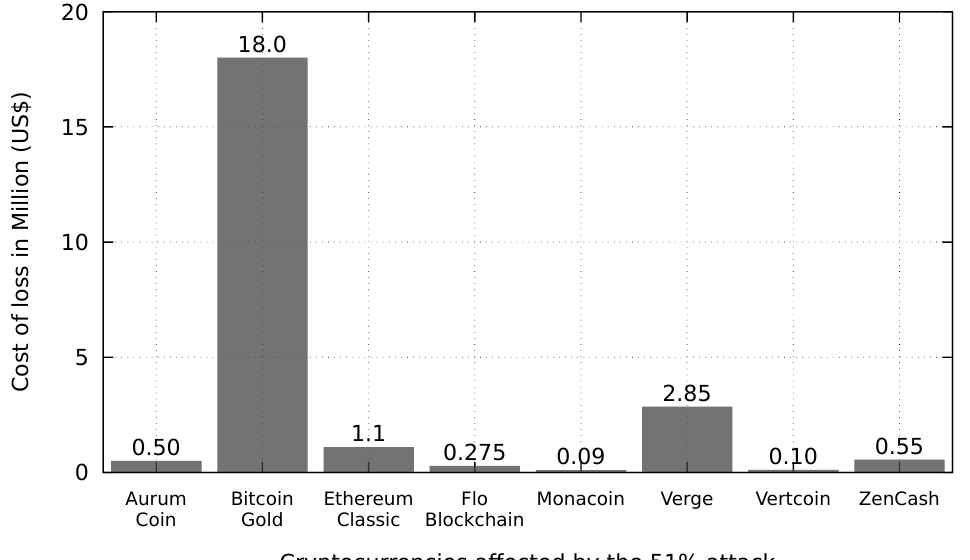
Figure 3. Loss from 51% attack on eight cryptocurrencies that have most recently been